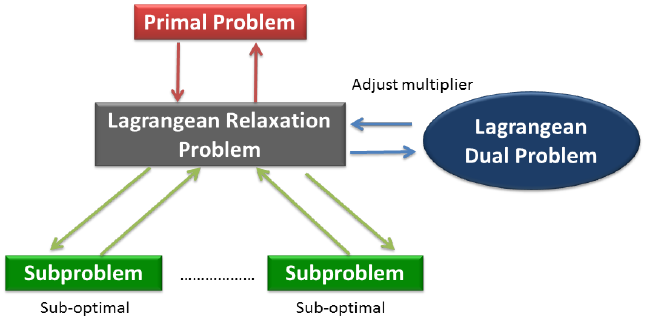
Figure 7. State diagram of Lagrangean Relaxation method.